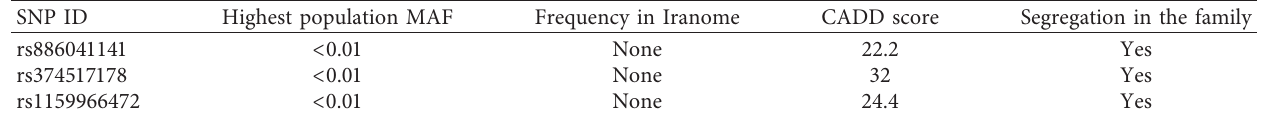
Table 2: Pathogenicity criteria for identified variants with no provided clinical